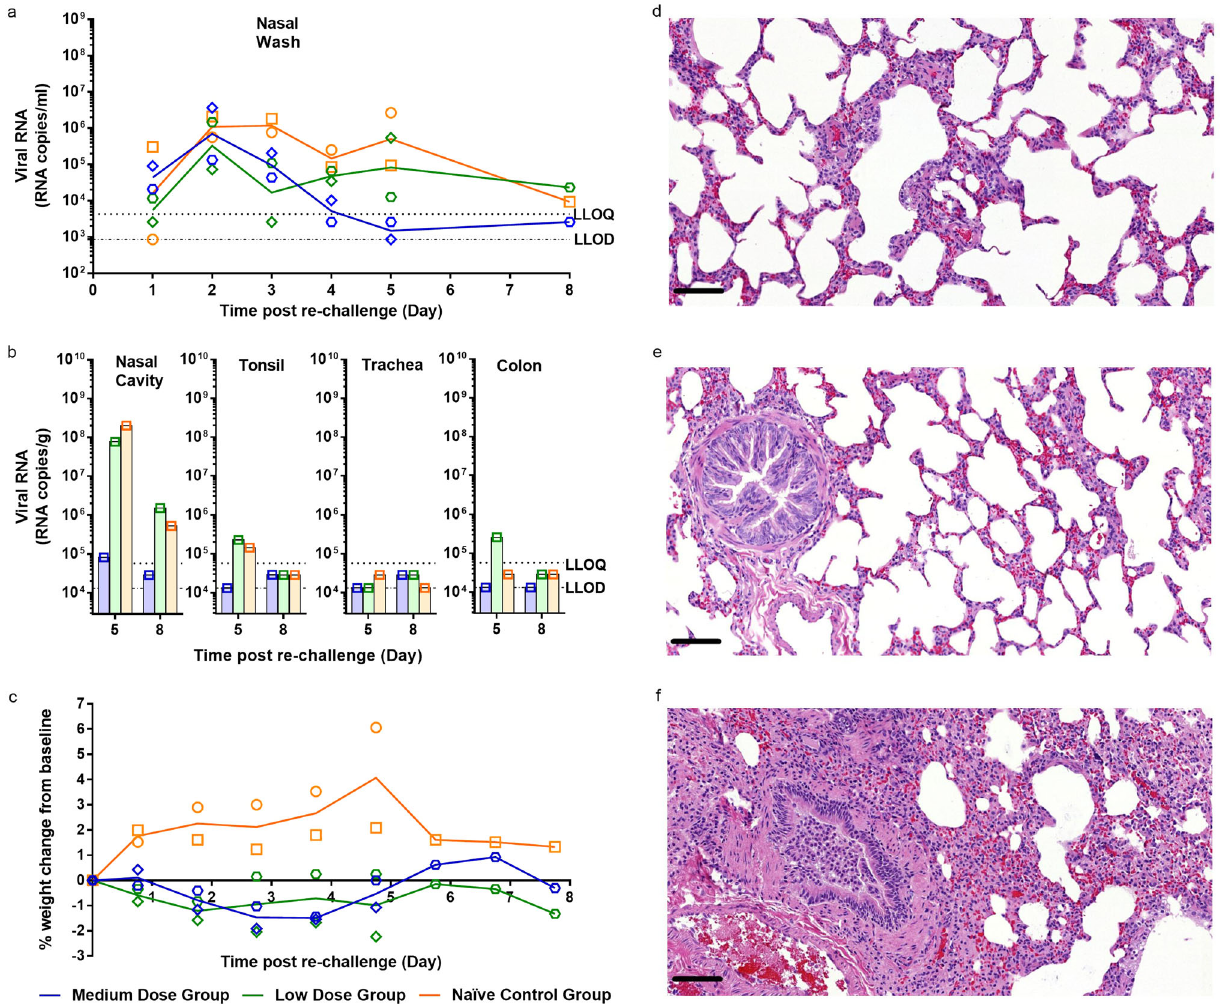
Fig. 5 Re-challenge of ferrets with SARS-CoV-2. a Nasal washes were collected at days 1 – 5 post re-challenge (days 29 – 33 post-original challenge). Viral RNA was quanti fi ed by RT-qPCR. b Nasal cavity, tonsil, trachea and colon were collected at euthanasia timepoints (days 5 and 8 post re-challenge) for all groups. Viral RNA was quanti fi ed by RT-qPCR. Bars show values for individual animals. The dashed horizontal lines show the lower limit of quanti fi cation (LLOQ) and the lower limit of detection (LLOD). c Percentage weight change from baseline. Baseline was calculated as average of the two most recent weights taken preceding re-challenge. n = 2 ferrets per group with numbers decreasing by 1 at 5 dpc. d Medium dose re-challenged ferret at day 5 post re- challenge. No remarkable changes in alveoli or terminal bronchiole. e Low dose re-challenged ferret at day 5 post re-challenge. No remarkable changes in alveoli or bronchiole. f Control group ferret challenged for the fi rst time (day 28 pc). In fl ammatory in fi ltration within bronchiolar lumen and mild in fi ltration of alveolar septa; lesions comparable with those observed in the original high dose group. Bar = 50 μ